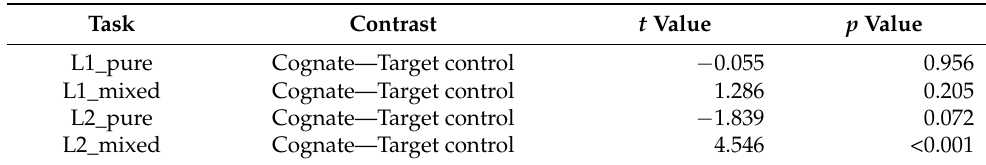
Table 6. Emmeans comparison of cognate versus target language control word processing within the four